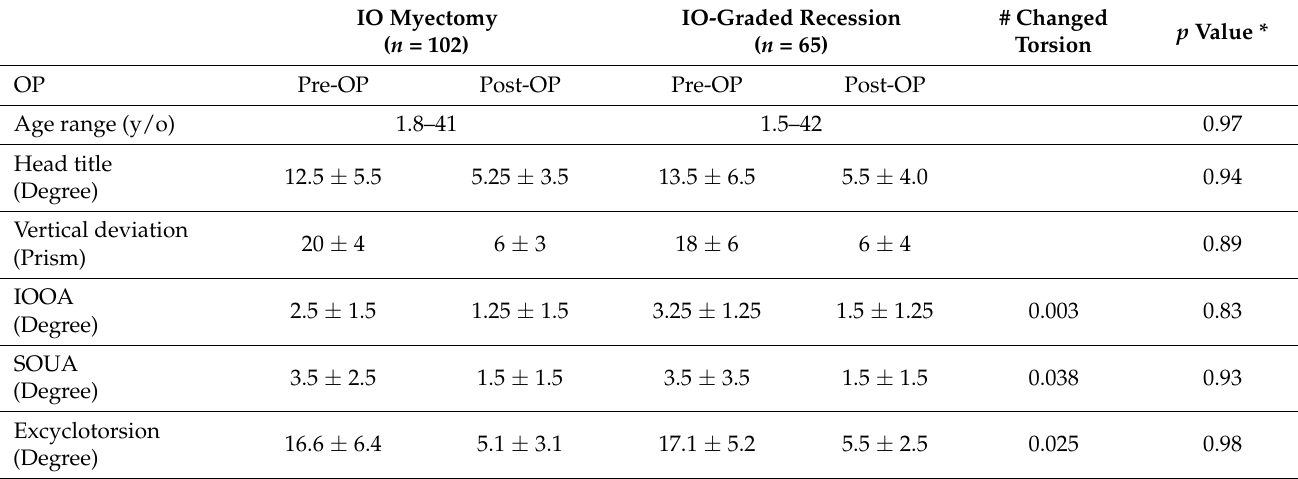
Table 1. Associated clinical factors and outcomes after inferior oblique muscle